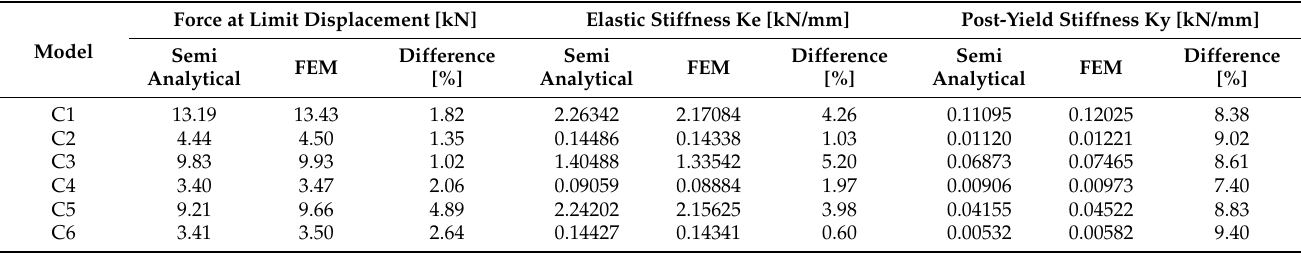
Table 6. Semi-analytical vs. numerical results for cantilever